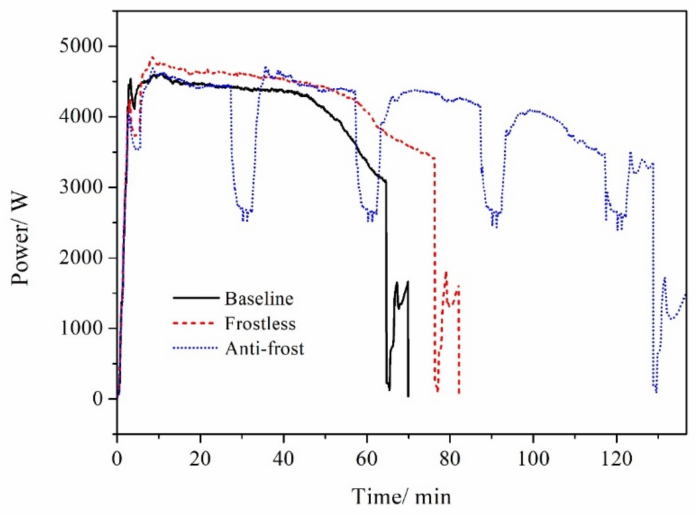
Figure 8. Power input of the ASHP for the three